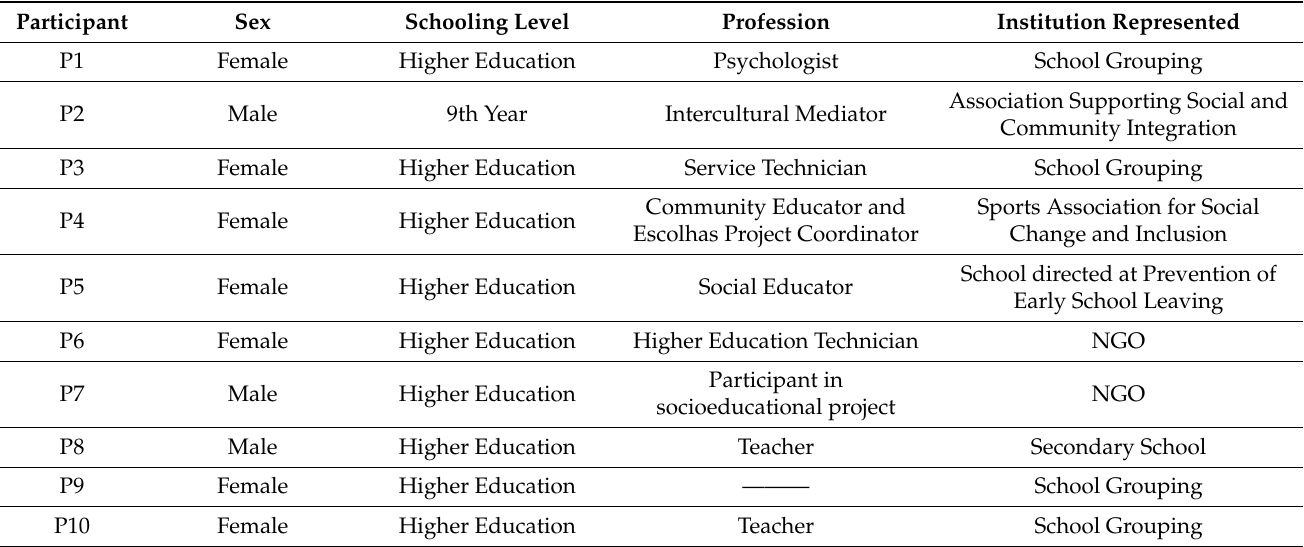
Table 3. Sociodemographic and professional characteristics of Focus Group 3